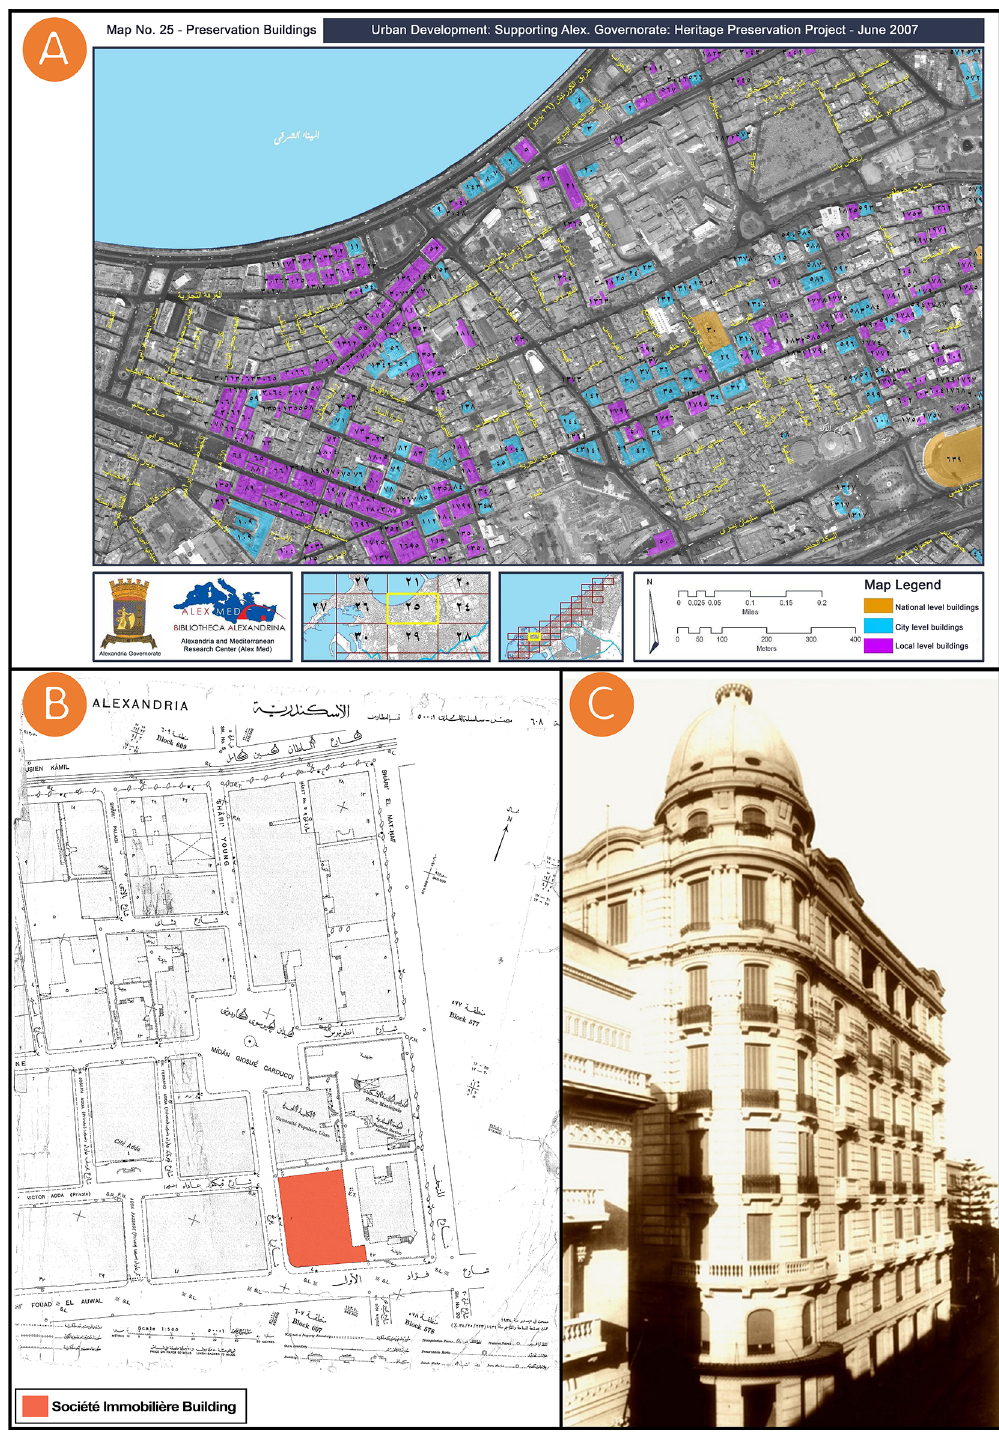
Figure 1. (A) The Société Immobilière building, “ item 33/ ٣٣ in Arabic numbering ” is registered under the National Urban Coordination System Volume 2007, the map was acquired from Alex Med of Bibliotheca Alexandrina; (B) Location of Société Immobilière building, 1938, the map was acquired from the City ’ s Municipal of Alexandria, Egypt; (C) Historic photo of Société Immobilière building, the photo was acquired from Sigma Properties Company. All of (A), (B), and(C) were gathered from open access sources, and available through institutes and their official websites.